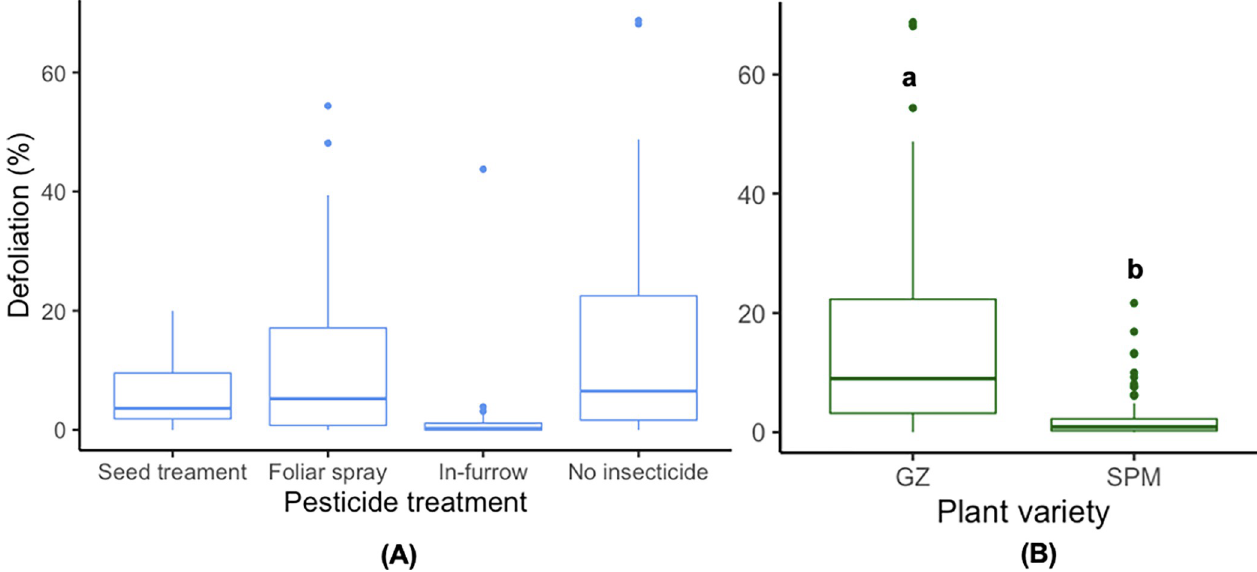
Fig 1. A. Percentage defoliation in squash plants treated with different thiamethoxam application methods. B. Percentage defoliation in two plant varieties of squash crops, GZ: Golden Zucchini, SPM: Success PM. Whiskers indicate the range of the defoliation found, excluding outliers. Upper, middle, and lower quartiles indicate the greatest, average, and lowest defoliation percentage estimated, respectively. Different letters indicate significant differences between levels of the treatment based on Tukey’s HSD post-hoc test (p < 0.05). (Table 2). Based on the Tukey’s HSD post-hoc test the combination of no insecticides and the plant variety Golden Zuchinni showed the highest number of dead plants compared to the rest of the treatments with no other differences among them (Fig 2).